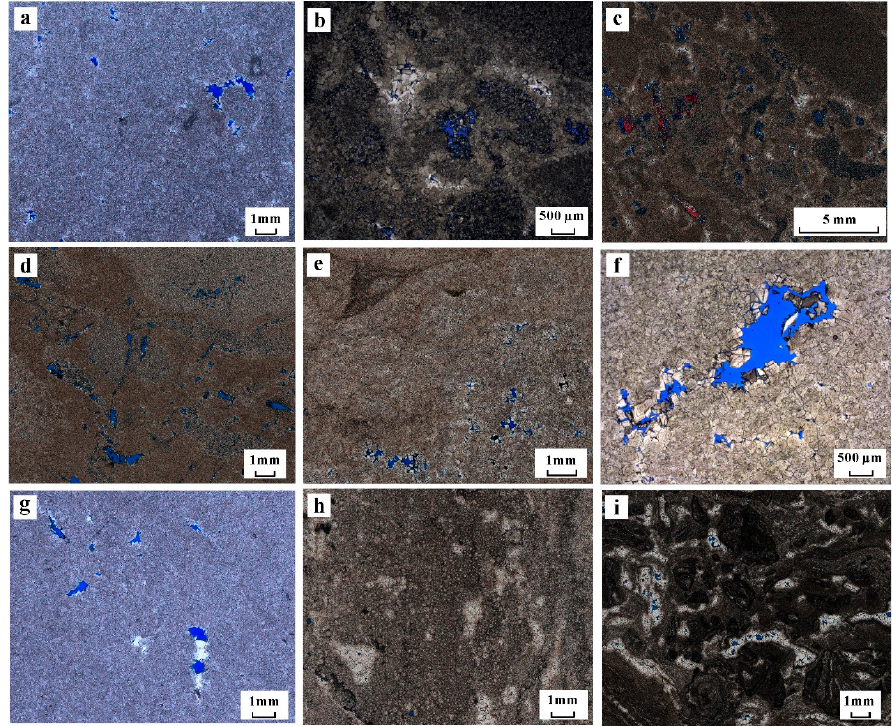
Figure 5. Plane polarized light microscopic images of porous dolostones in the Xiaoerbulake Forma- tion from the Shihuiyao section. ( a ) Rock Type i, fabric-obliterated fine-crystalline dolostone with grain ghosts, intercrystalline pores, and intercrystalline pores. ( b ) Rock Type ii, rubble dolostone, intercrystalline pores. ( c ) Rock Type ii, rubble dolostone, intercrystalline pores, some intercrystalline pores filled with calcite. ( d ) Rock Type iii, the thrombolite dolostone with fabric obliterated by dolomitization or recrystallization, dissolution enlarged pores and fissures. ( e ) Rock Type iii, the thrombolite dolostone with fabric obliterated by dolomitization or recrystallization, intercrystalline pores. ( f ) Rock Type iv, crystalline dolostone, dissolution enlarged pores and intercrystalline dissolu- tion pores. ( g ) Rock Type iv, crystalline dolostone, intercrystalline pores, and intercrystalline pores. ( h ) Rock Type v, foam spongy texture silty crystalline dolostone with fabric partly preserved. ( i ) Rock Type vi, oncolite dolostone, intercrystalline pores, and intercrystalline